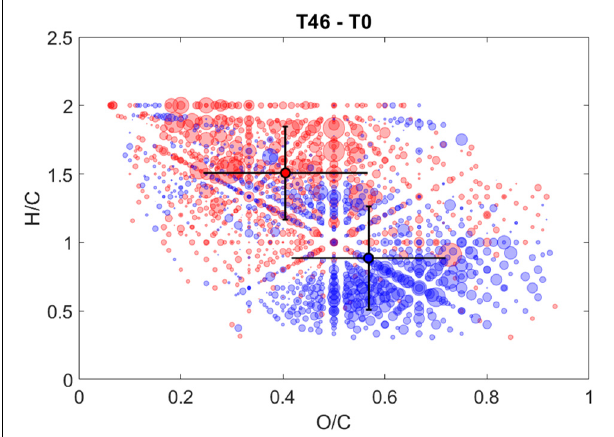
FIGURE 5 | Hydrogen to carbon (H/C) ratios versus oxygen to carbon (O/C) ratios of CHO formulas that either relatively increased in intensity (red circles) or relatively decreased in intensity (blue circles) after 46 h of irradiation. Total photon dose after 46 h during this experiment was comparable to a photon dose of ∼ 20 h for the experiments discussed in section “Photodegradation of Sargassum DOM Optical Properties.” Bubble size corresponds to peak intensity and dark circles with error bars are the intensity-weighted average H/C and O/C ratios of relatively increasing (red circle) and relatively decreasing (blue circle)